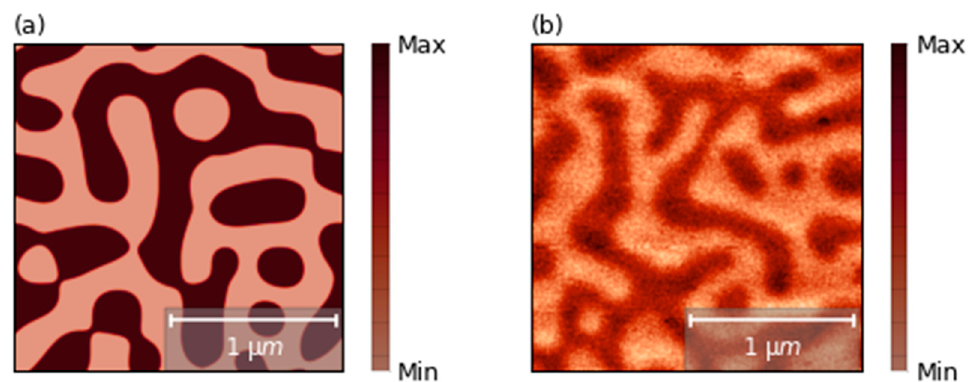
Figure 2. ( a ) The simulated domain distribution of the ultrathin films with seven repetitions of Pt/Co/Au with fitted exchange constant: A = 1.0 × 10 − 11 J/m. ( b ) MFM image of the domain distribution in ultrathin non-patterned Pt/Co/Au multilayer with seven repetitions.